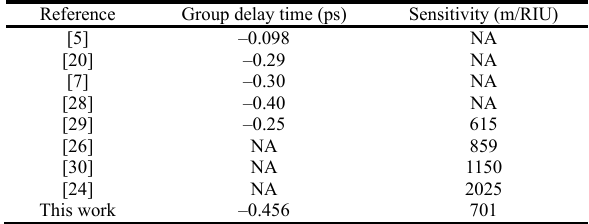
Table 1 Comparison of the proposed device and other published